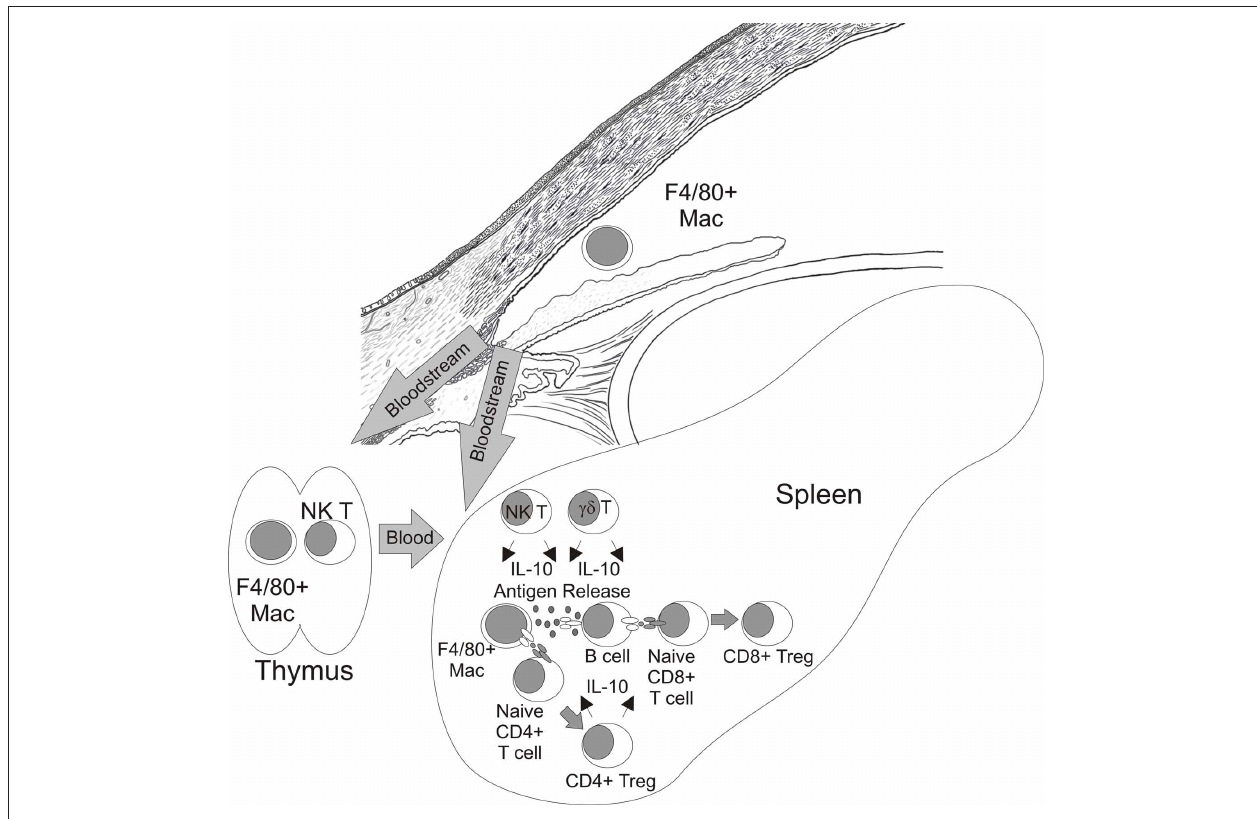
FIGURE 4 | Paradigm of CD8 + Treg generation in